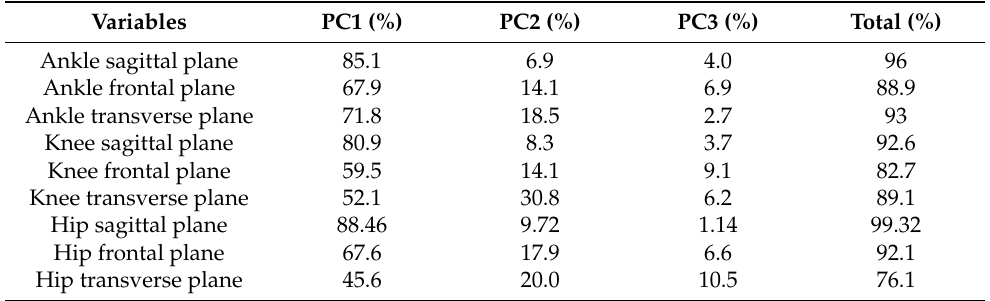
Table 1. The first three principal components for the sagittal, frontal and transverse angle waveforms during the running stance phase.